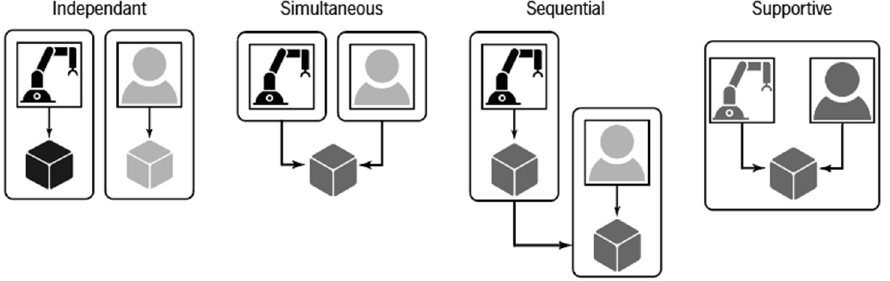
Figure 1. Different levels of HRC.